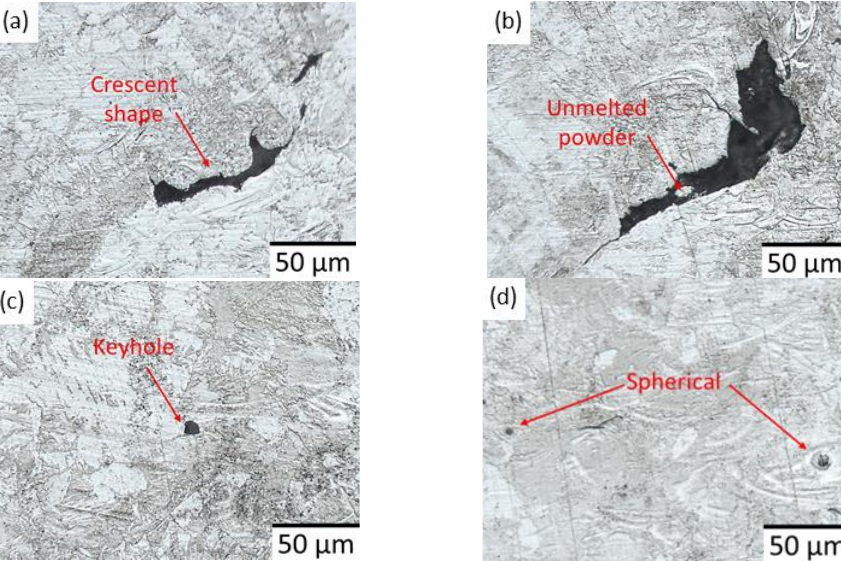
Figure 14. The types of porosity observed from three different areas of 45° build direction; ( a ) crescent shape, ( b ) unmelted powder, ( c ) keyhole and ( d ) spherical porosity.